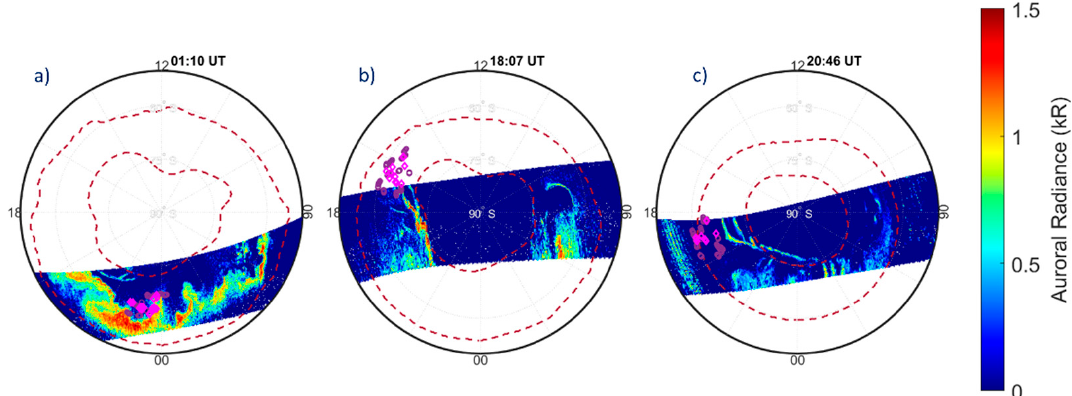
Figure 8. Polar-view maps in AACGM latitude and MLT of the austral auroral radiance as measured by SSUSI instrument in the LBHL band at 01:10 UT ( a ), 18:07 UT ( b ) and 20:46 UT ( c ) on 8 September 2017. Each map also reports the auroral oval boundaries location (red dashed contours), as retrieved from the auroral radiance data, the σ ϕ greater than 0.25 rad (magenta diamonds), recorded at SANAE IV base during the DMSP passage, and all the σ ϕ values having elevation angle α = 30 ◦ (purple circles). GNSS data were projected to 350 km altitude. Each map covers 00:00–24:00 MLT and |50 ◦ |–|90 ◦ | AACGM Lat, the magnetic noon/midnight is at the top/bottom.